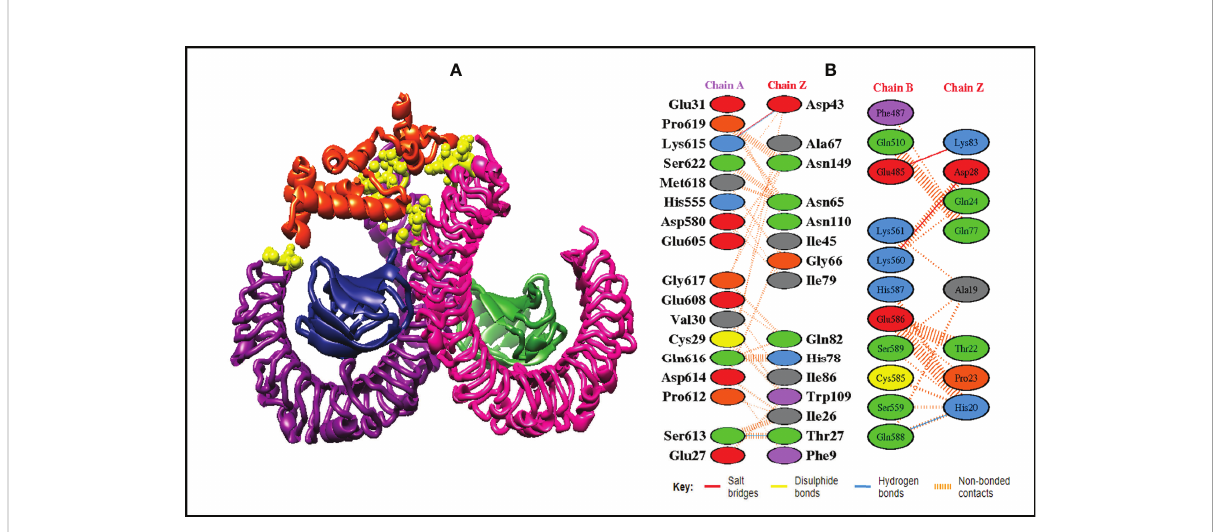
FIGURE 8 Schematic illustration of MEMPV-TLR4 docked cluster. (A) Docked pose of MEMPV-TLR4 docked cluster. Each chain of TLR4 receptor is represented in a different color, i.e. chain A: dark magenta, chain B: deep pink, chain C: navy blue, and chain D: forest green, construct in orange-red and interacting residues between immune receptor and vaccine are shown in yellow color. (B) Dimplot of vaccine construct and TLR4 docked